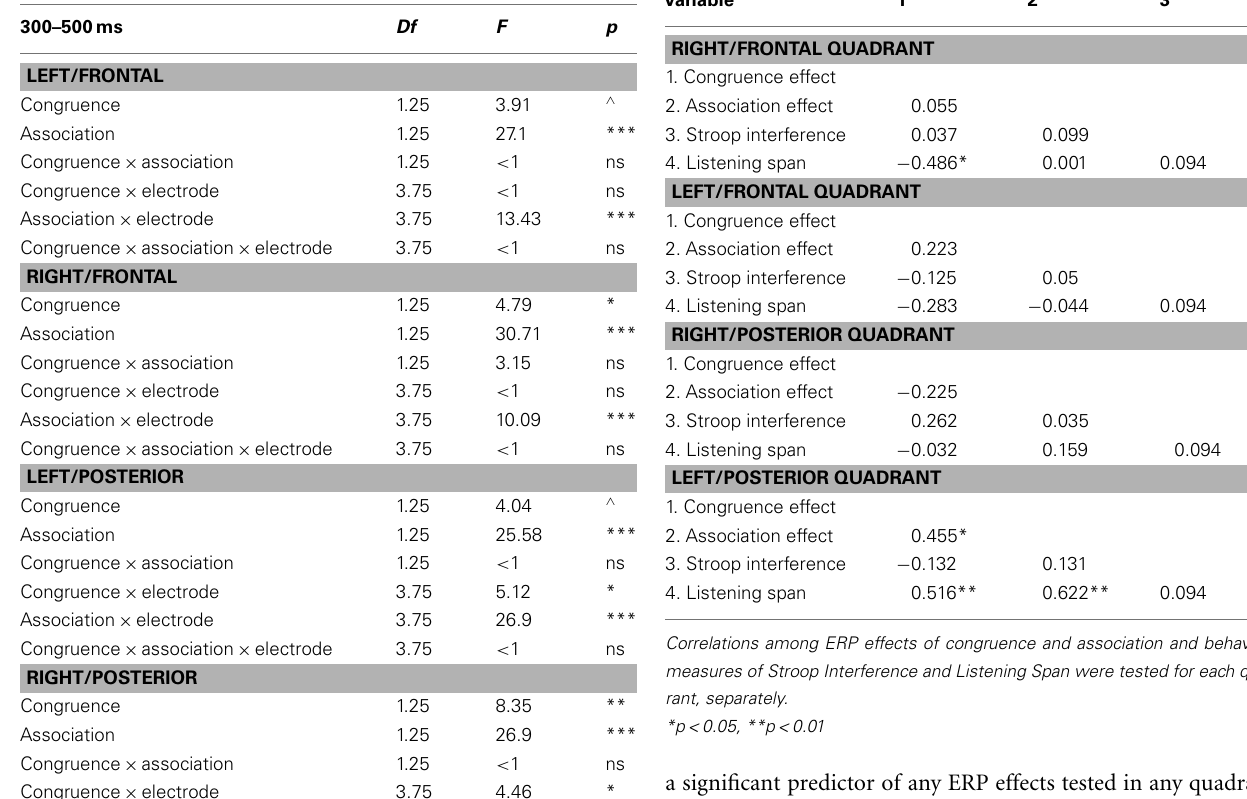
Table 3 | Results of discourse congruence and lexical association from repeated measuresANOVA, for each quadrant separately.